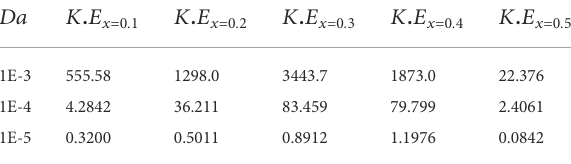
TABLE 4 Variation in kinetic energy ( K . E ) against the Darcy number ( Da ) . Da K . E x (cid:2) 0 .